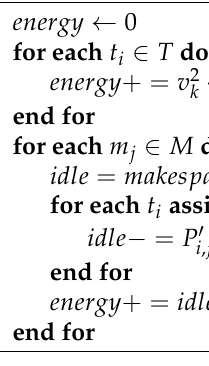
Algorithm 2 Energy objective